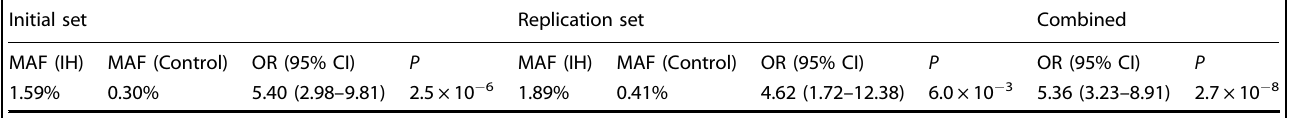
Table 1. Signi fi cant association between rs537376938 (p.Lys68Arg) in prepro-orexin and IH. Initial set Replication set